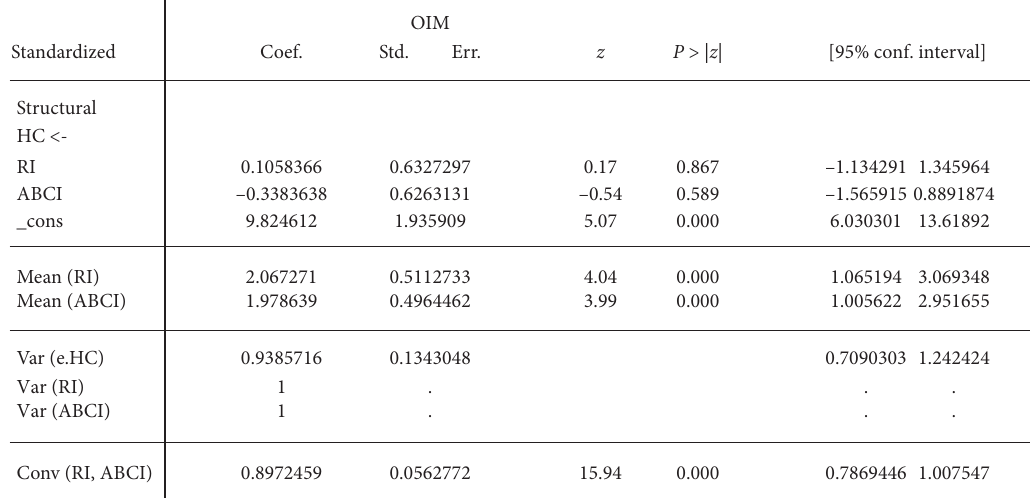
Figure 11: Tabular form of the magnitude of the effectiveness of ABCI and RI over HC as shown in Figure